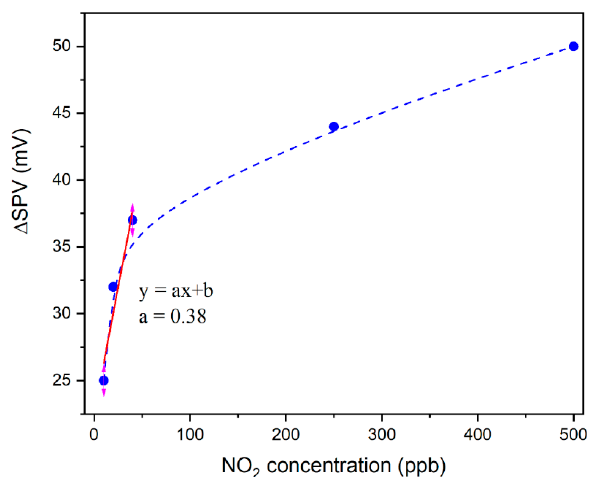
Figure 2. The variation of amplitude of surface photovoltage (SPV) signal corresponding to the gas sensor response for RGVO SnO x nanolayers as a function of the relative concentration of NO 2 in the synthetic air in the range: 10–500 ppb; the dashed line is a guide to notice; the linear function used for the calculations of the detection limit.